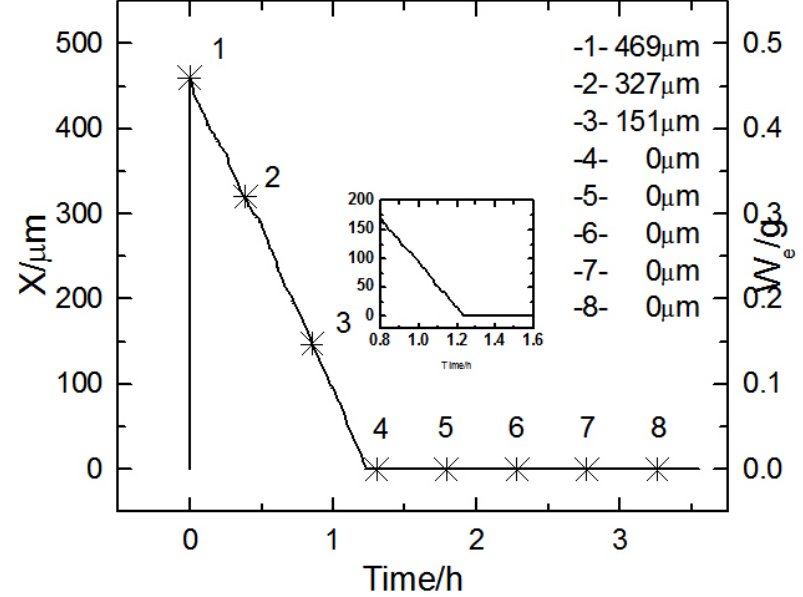
Figure 4. Plots of electrolyte film thickness X vs. time during 1 st cycle